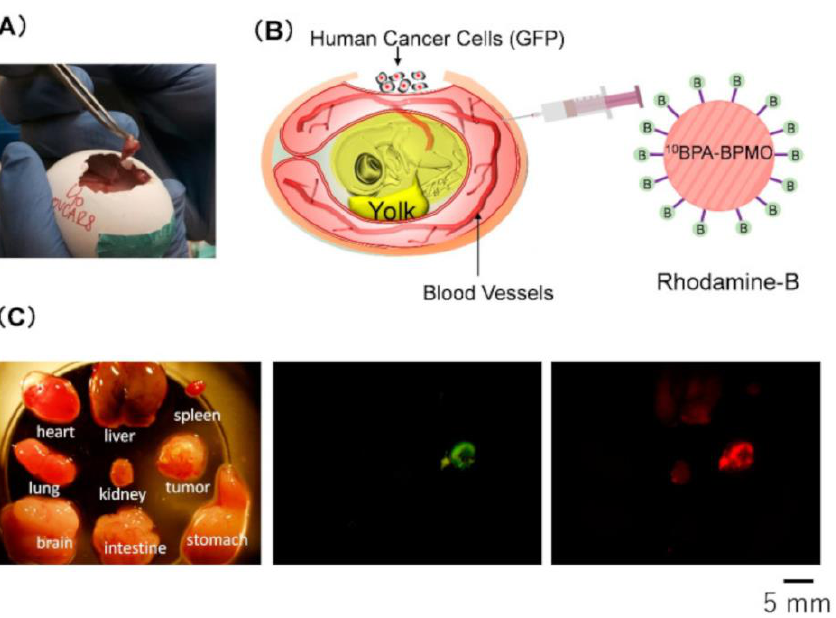
Figure 1. ( A ) Tumor formation on the CAM by transplanting cancer cells; ( B ) a CAM-based assay to examine tumor accumulation of nanoparticles. The tumor is formed using green fluorescence protein (GFP) expressing cells; ( C ) detection of 10 BPA-BPMO in tumor. Reproduced from [92] under